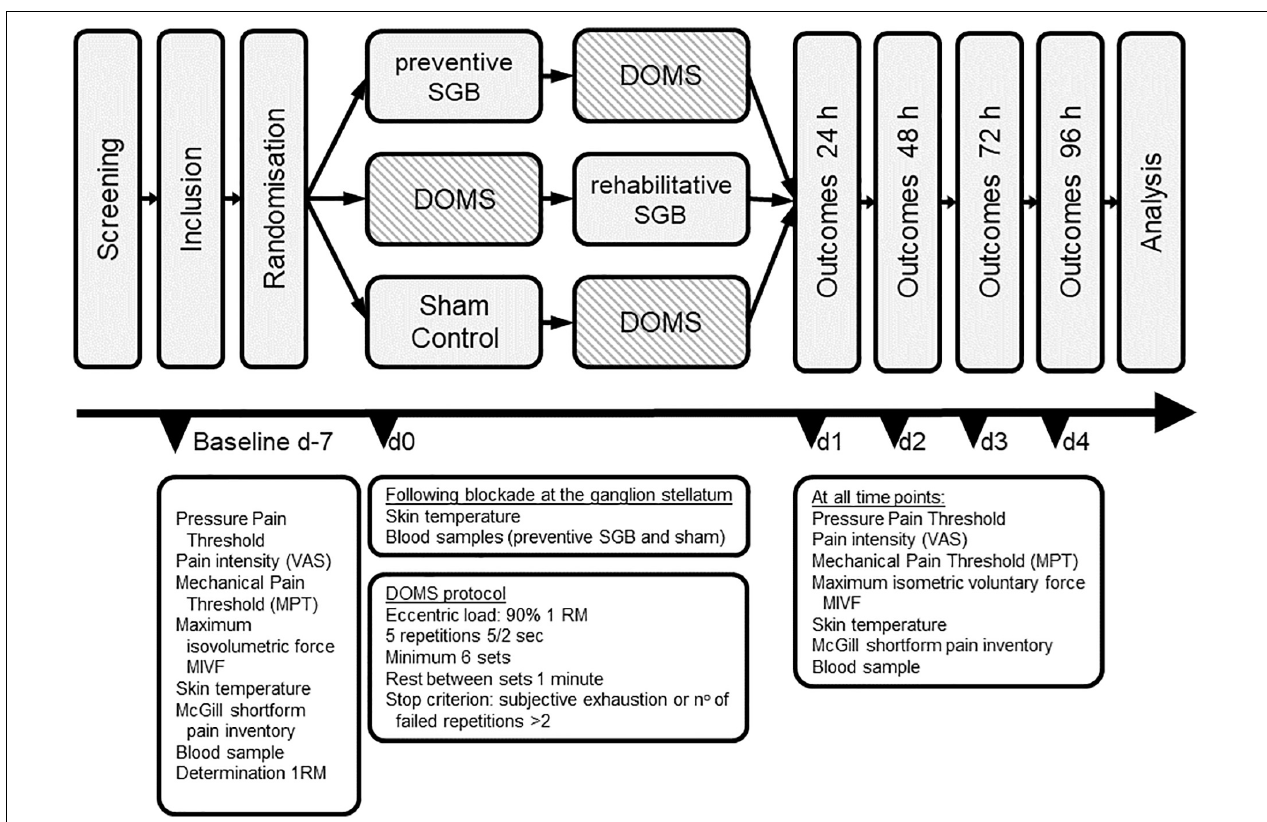
FIGURE 1 | Trial design. Baseline measures were assessed at 7 days (d-7). After randomization, DOMS was induced at day 0 (d0), and outcomes were measured at indicated timepoints until 96 h after DOMS induction. SGB stellate ganglion block.